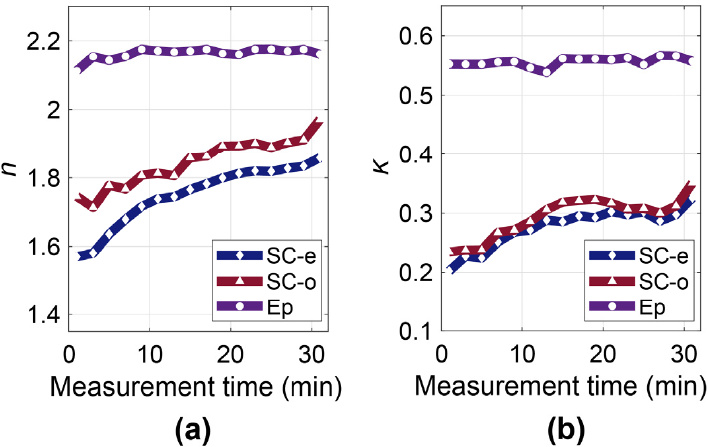
Figure 14. ( a ) The refractive index and ( b ) extinction coefficient of the SC in the extraordinary and ordinary directions and epidermis at 0.6 THz during 30 min of occlusion [53].